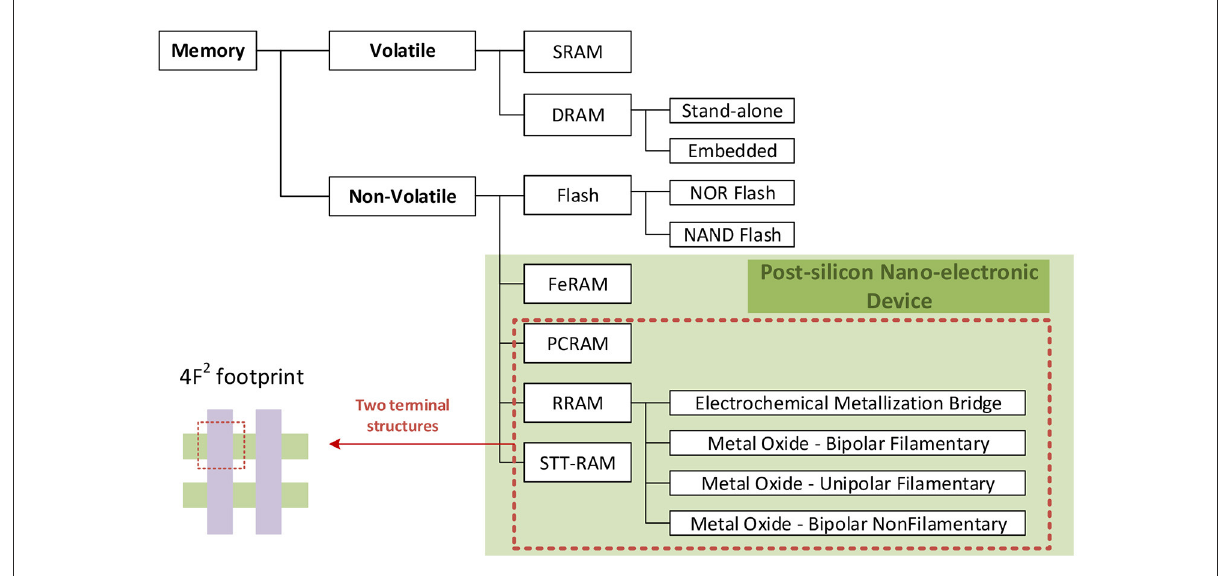
FIGURE5 The categories of semiconductor memory.